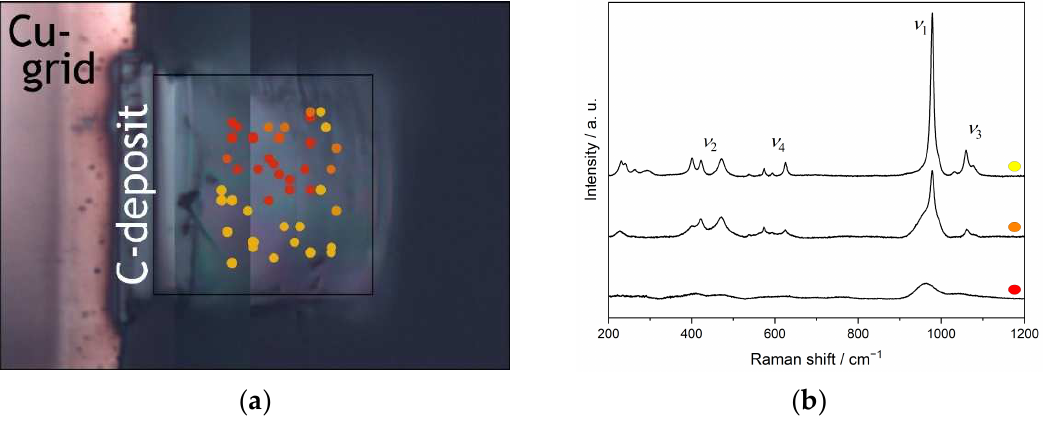
Figure 10. Raman measurement points on SmPO 4 FIB lamellae ( a ) and respective spectra ( b ) indi- cating variations in crystallinity in the sample after triple irradiation with multi-energy Au ions at the max. total fluence (F3) of 5.1 × 10 14 ions cm −2 ; the colour coding of the measurement points ( a ) refers to areas of different crystallinity as indicated in the Raman spectra ( b ) (Figs. modified ( a ) and reproduced ( b ) from [56]).